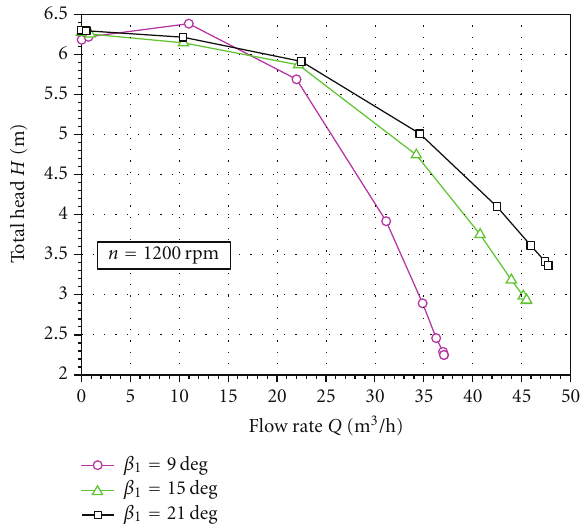
Figure 8: The total e ffi ciency as a function of the flow rate, studying the noncavitating